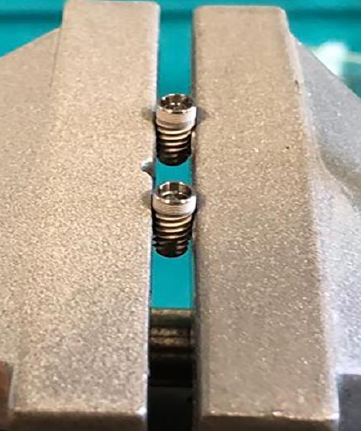
Figure 1. Dental implants placed in a sterile clamp.